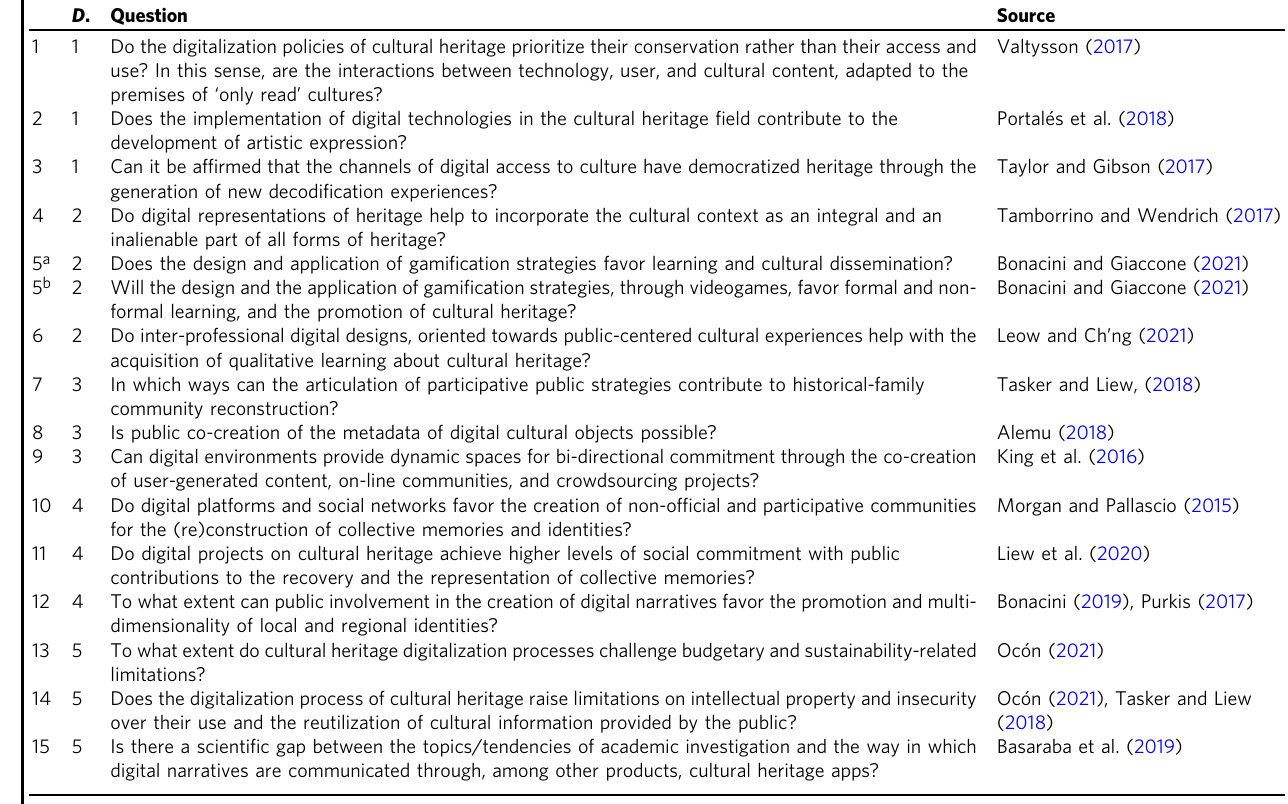
Table 1 Validated version of